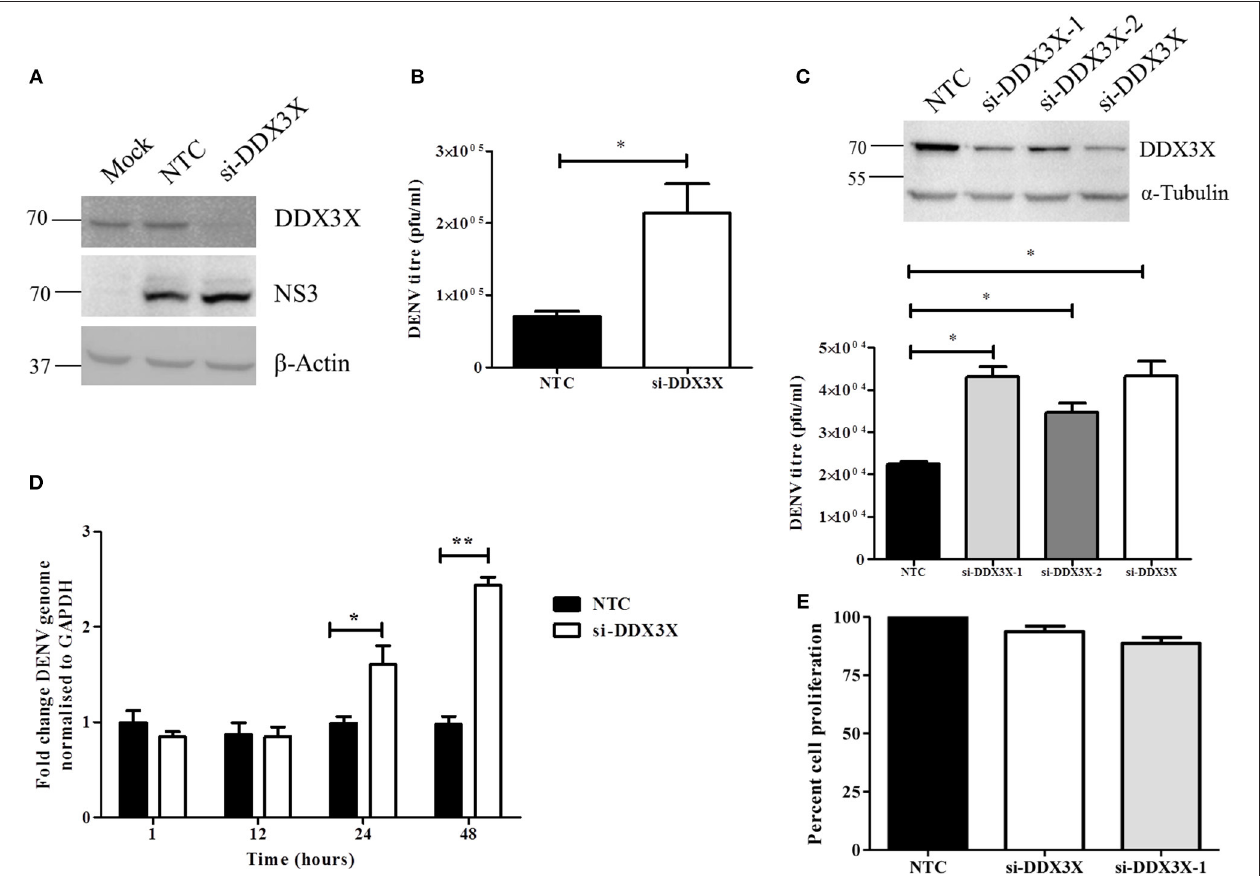
FIGURE 4 | Knockdown of DDX3X enhances DENV infection. Knockdown of DDX3X was performed in Huh-7 cells using smartpool siRNAs (si-DDX3X) and at 48h p.t cells were infected with DENV at 1 MOI. Viral titres and RNA levels were verified at 24h p.i. (A) Western blot analysis to verify knockdown of DDX3X. β -actin level is shown as a loading control and DENV-NS3 antibody was used to detect infection levels. (B) Viral titers were estimated by plaque assay. (C) DDX3X expression was knocked down by a single siRNA (si-DDX3X-1 or si-DDX3X-2) or using smartpool siRNAs (si-DDX3X) in Huh-7 cells and 48h p.t. cells were infected with DENV at 1 MOI. Upper panel shows the western blot for knockdown efficiency. Lower panel shows viral titres estimated at 24h pi. Figure is representative of three independent experiments performed with triplicate samples (D) Kinetics of infection in Huh-7 cells after DDX3X knockdown. Cells were collected at 1, 12, 24, and 48h pi and DENV genome levels were estimated by real-time PCR. Data from two independent experiments performed with triplicate samples ( n = 6) is represented as mean ± SEM. (E) Knockdown of DDX3X was performed in Huh-7 cells using smartpool siRNAs (si-DDX3X) and single siRNA (si-DDX3X-1) and cell proliferation was assessed as described in the methods section at 48h post-transfection. * P < 0.05 and ** P < 0.005.